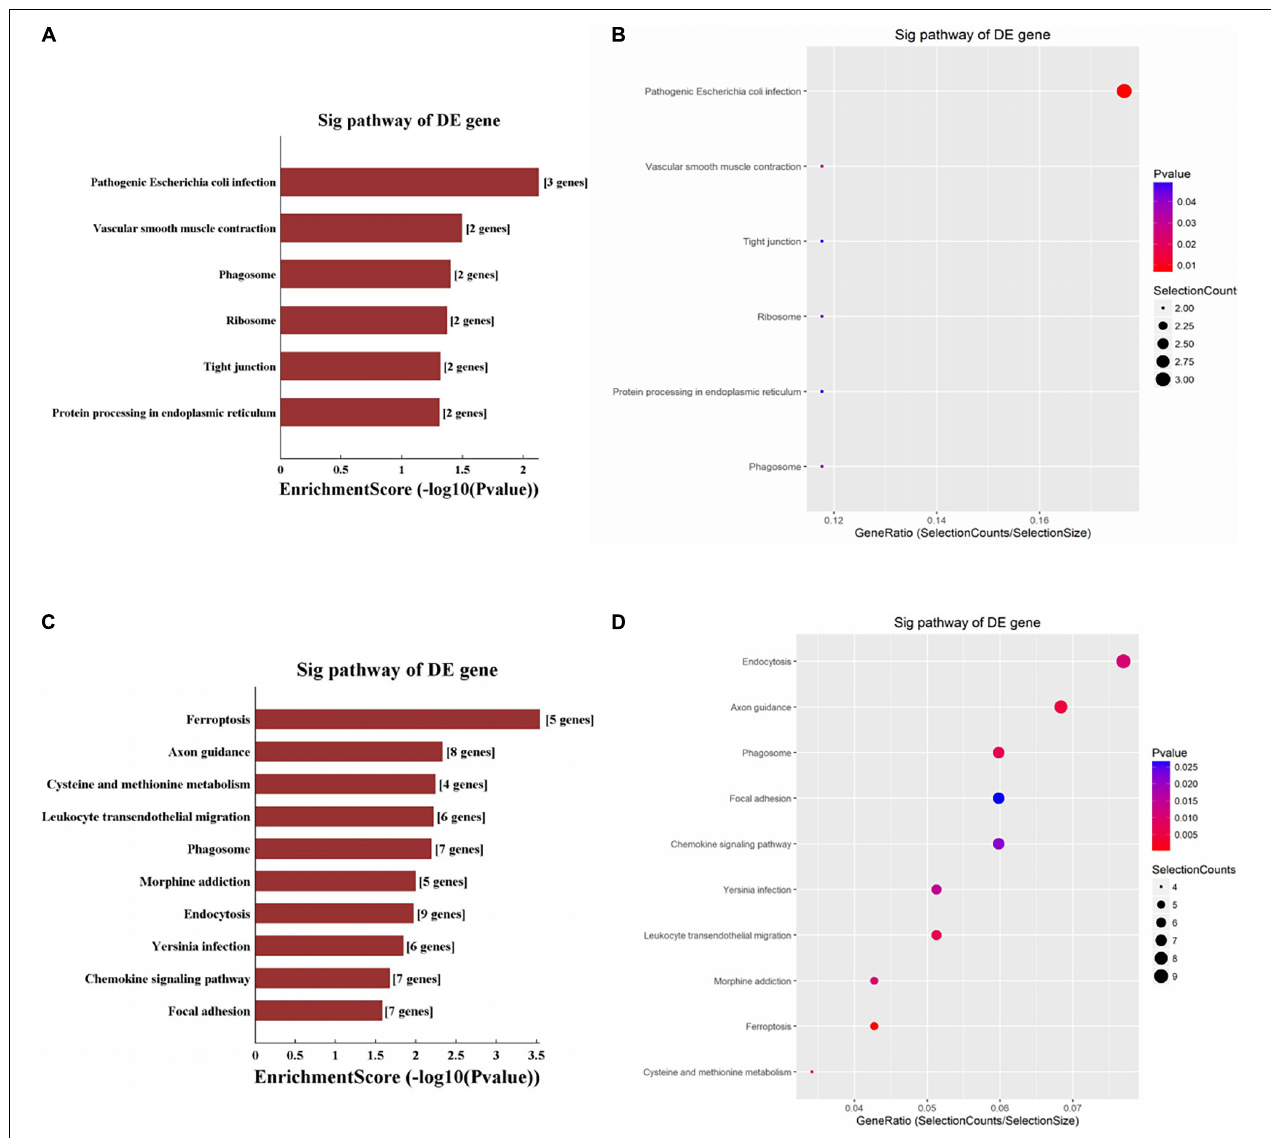
FIGURE 4 | KEGG enrichment analysis of circRNAs. For bar plot and bubble plot, the y-axis shows the enriched pathways of genes and the x-axis shows the Enrichment Score [ − log10( P -value)] or GeneRatio (Count/List. Total): (A,B) upregulated circRNAs, (C,D) downregulated